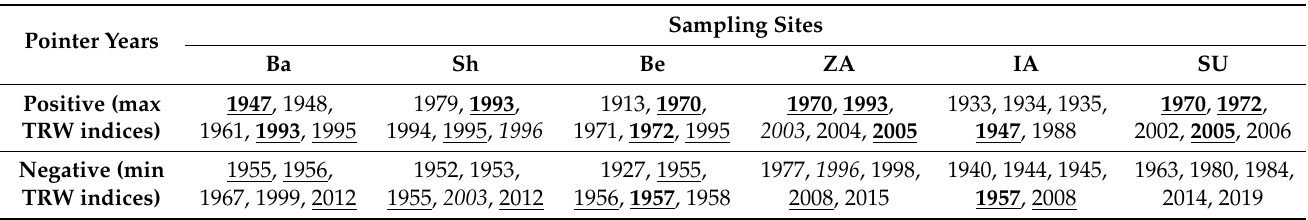
Table 5. Pointer years (years with the highest/lowest tree-ring width indices within cover period of climatic series) at each sampling site (Ba—Bayanaul, Sh—Shalday, Be—Beskaragay, ZA—Zhongar- Alatau, IA—Ile-Alatau, and